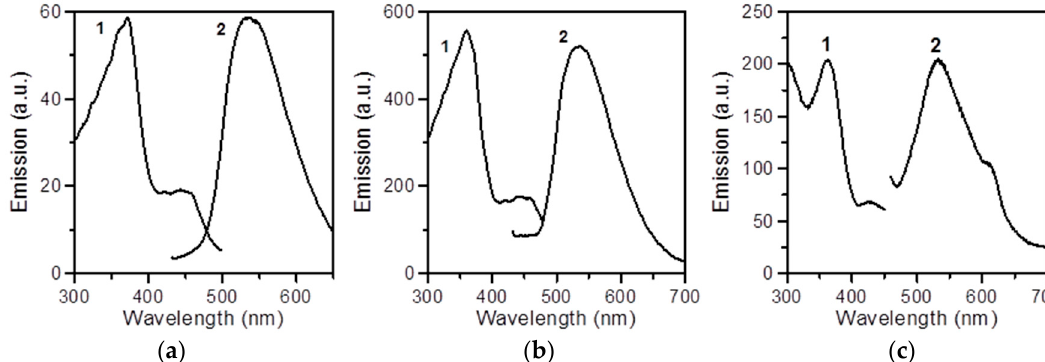
Figure 11. ( a ) Solid-state, room-temperature excitation (curve 1, maximum emission at 545 nm) and emission (curve 2, maximum excitation at 360 nm) spectra of free salanH, ( b , c ) Solid-state, room-temperature excitation (curve 1, maximum emission at 540 nm) and emission (curve 2, maximum excitation at 360 nm) spectra of complexes 4 · MeCN_Eu and 15 _Eu, respectively.